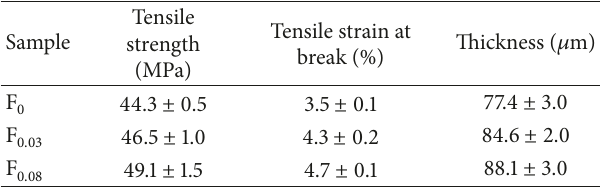
Table 3: Tensile testing results of composite films (F 0 , F 0.03 ,